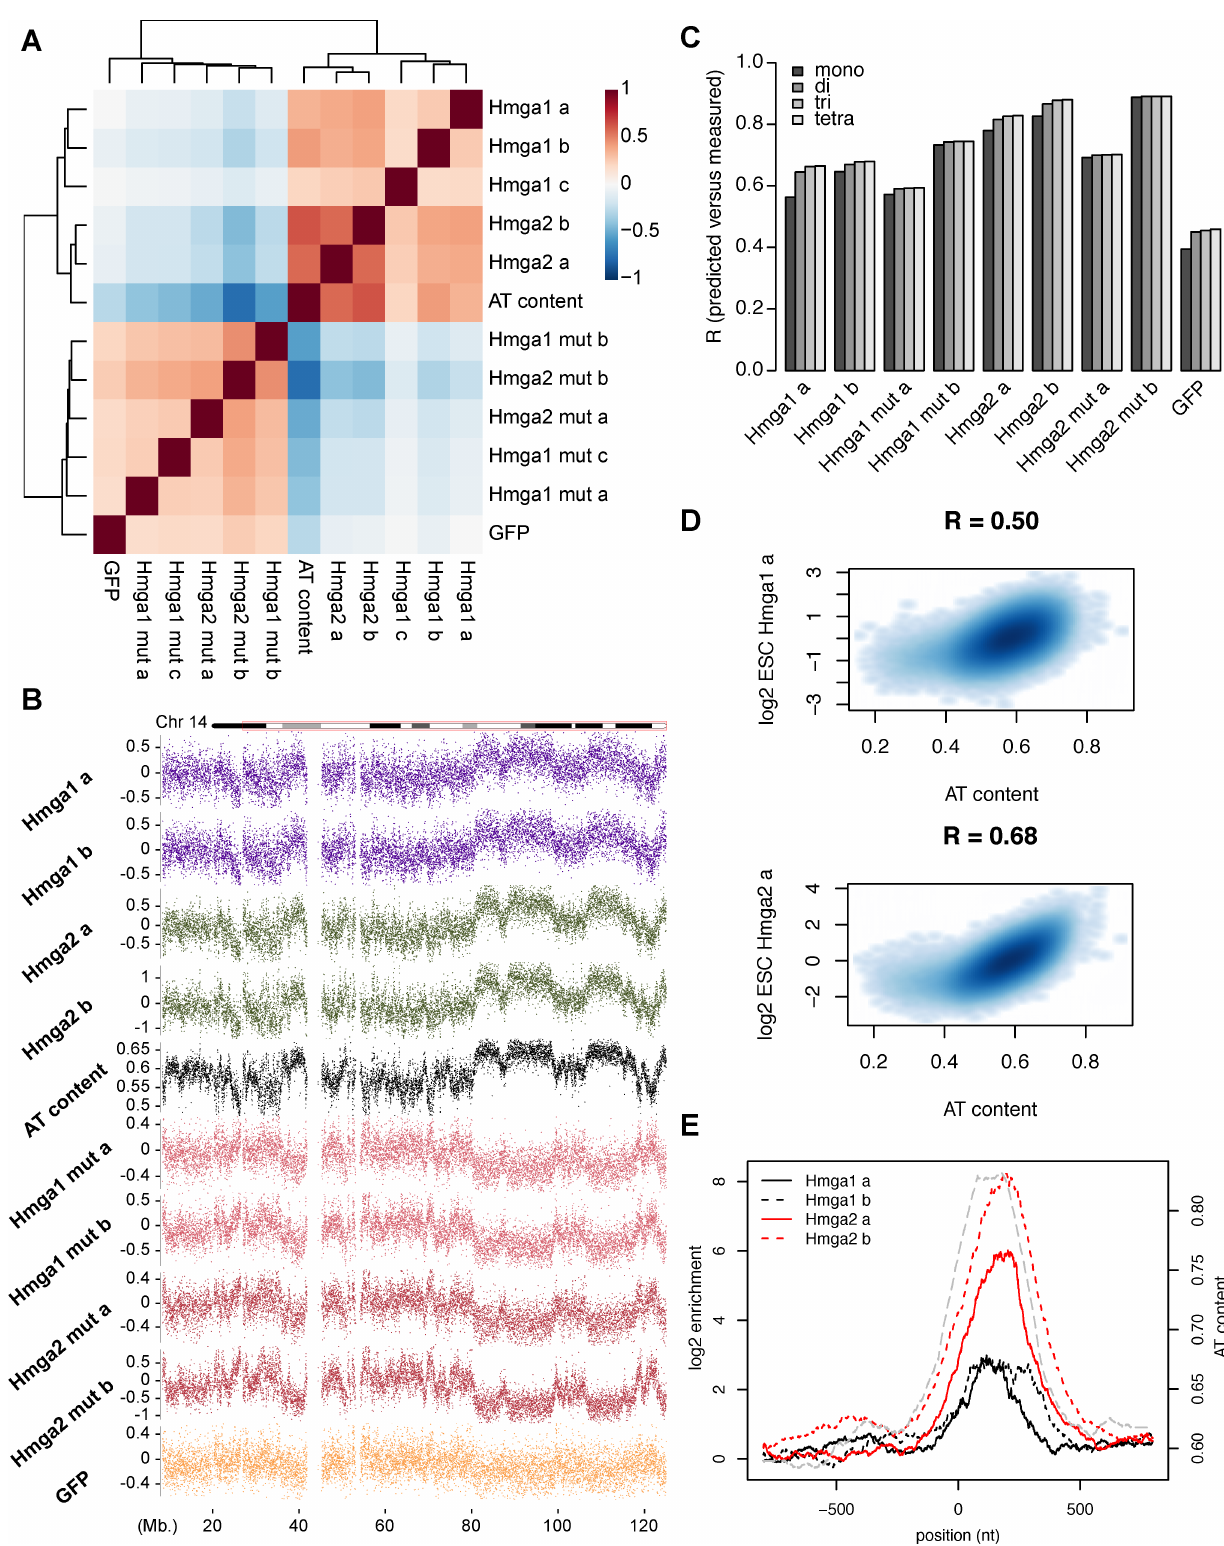
Fig 2. Hmga proteins bind to DNA in ESC as a function of DNA AT content. (A) Genome-wide correlationheatmapfor all samples (includingreplicatec of Hmga1) and AT content on 1kb tiling windows, illustrating both good reproducibility betweenreplicates and the